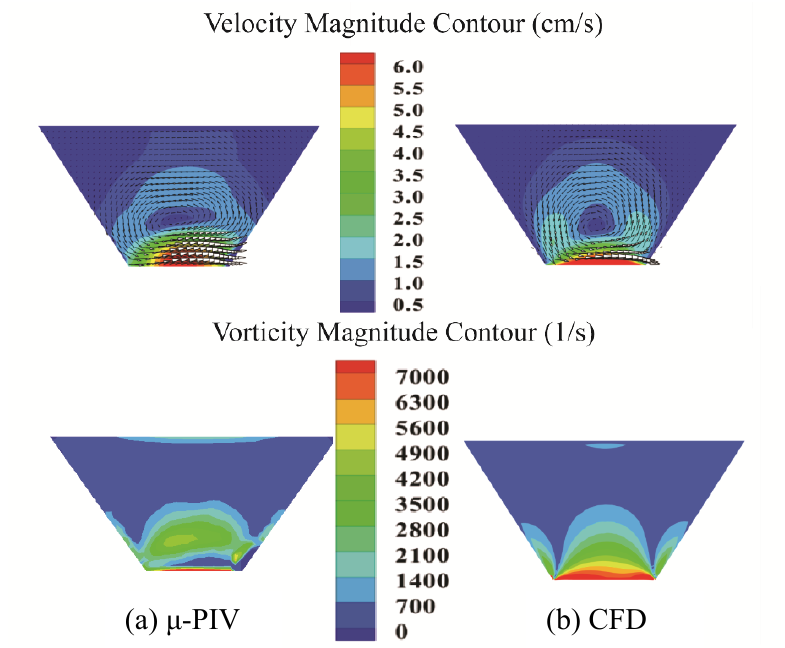
Figure 4. Velocity and vorticity magnitude contours from µ-PIV ( a ) and CFD ( b ) for the trapezoid-shaped side